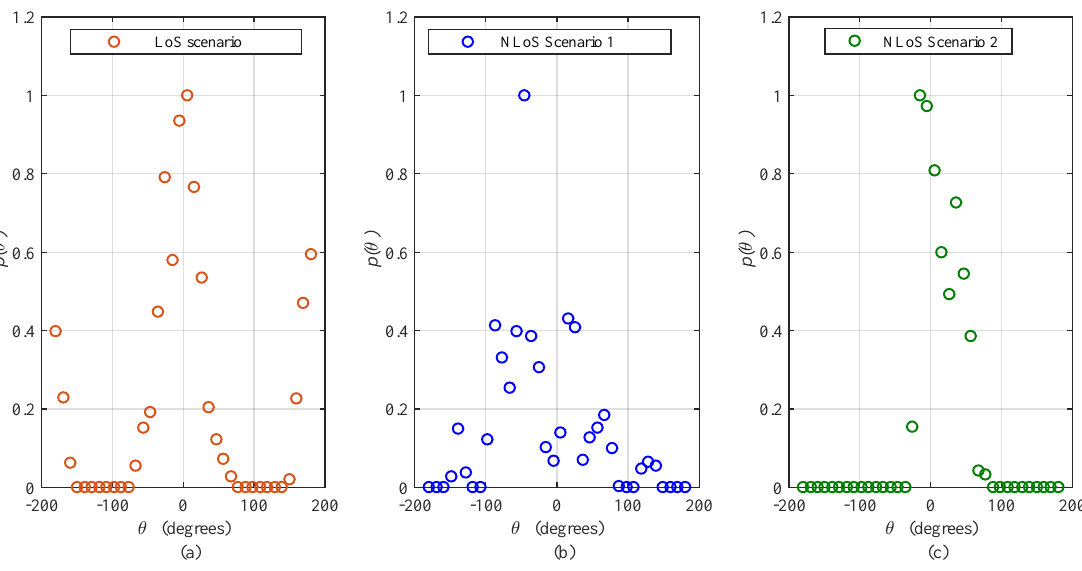
Figure 3. Angular distribution of multipath power with respect to azimuth AoA for different indoor mmWave (28 GHz) radio propagation environments; obtained after performing numerical integration along delay domain, data calibrations, and normalization operations on the measurement results provided in [6]. ( a ) LoS Scenario, Figure 8b of [6]; ( b ) NLoS Scenario 1, Figure 8e of [6]; ( c ) NLoS Scenario 2, Figure 8h of